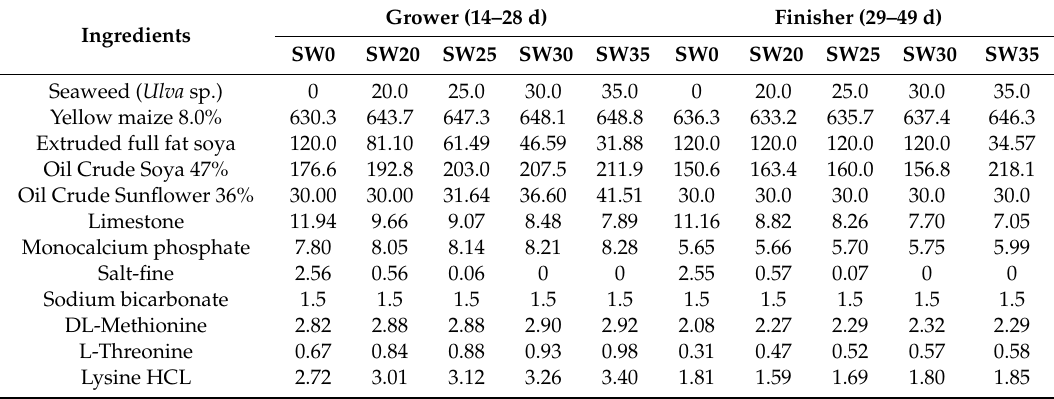
Table 1. Gross ingredient composition (g / kg, as fed basis) of experimental diets in grower and finisher